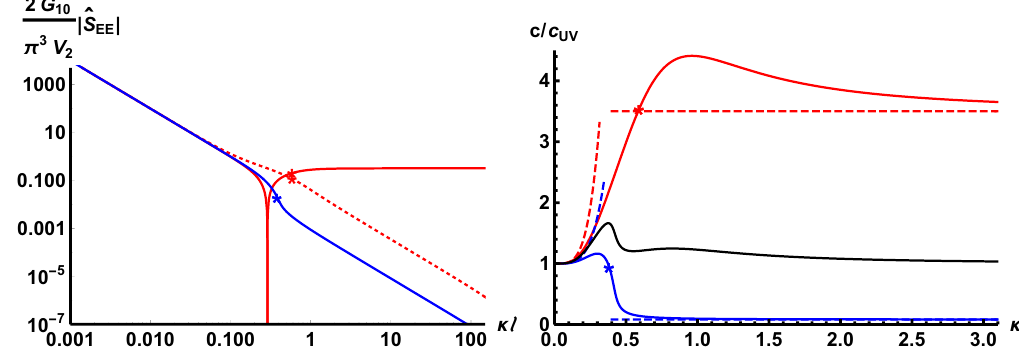
Figure 4 . Left: the (absolute values of the) regularized entanglement entropies for the in-plane ( k ,blue) and for the o(cid:11)-plane ( ? ,red) with the constant part in (3.23) subtracted for the dotted curve to illustrate the ‘ (cid:0) 2 behaviors for the asymptotically narrow and wide slabs. Right: the c -functions for the boomerang (cid:13)ows. We chose as parameters n = 3 ; m = 2, but the results are qualitatively the same for other values. The (cid:13)avor parameter we picked sizable Q f = 10 to pronounce the features. The solid curves are produced numerically, while the dashed curves follow from the asymptotic UV and IR analytics (C.23) and (3.25), respectively. The black curve is the average c -function de(cid:12)ned in